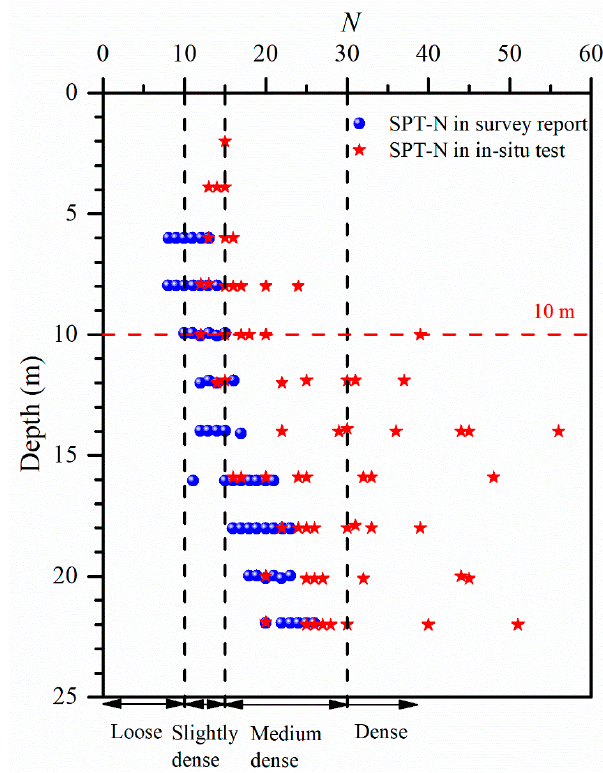
Figure 12. Penetration depth versus the blow count (N) of the standard penetration test (SPT) (SPT-N).